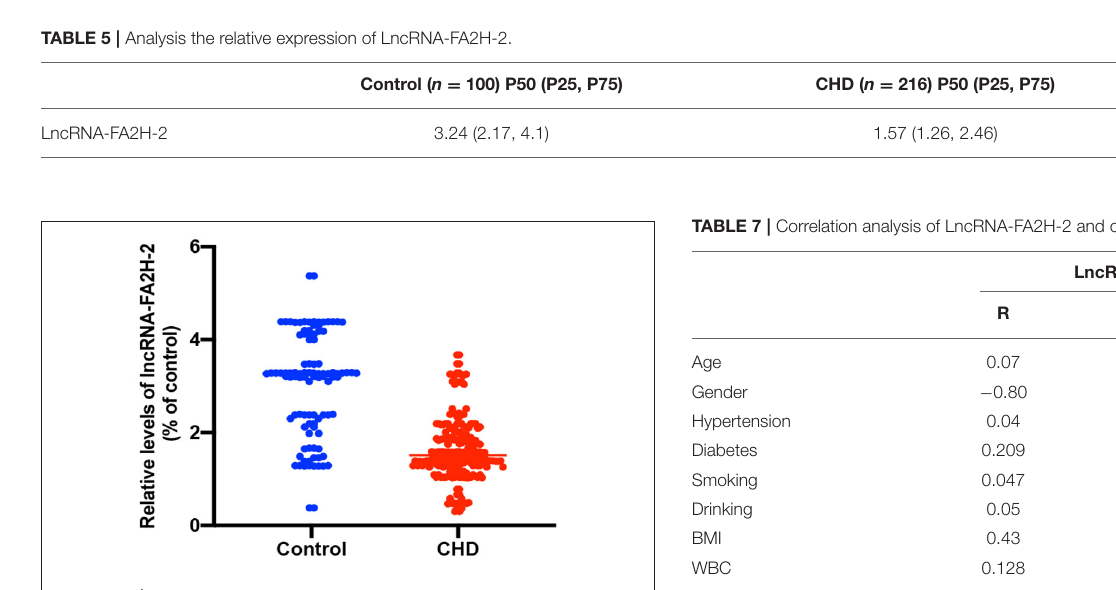
FIGURE 2 | Analysis the relative expression of LncRNA-FA2H-2.